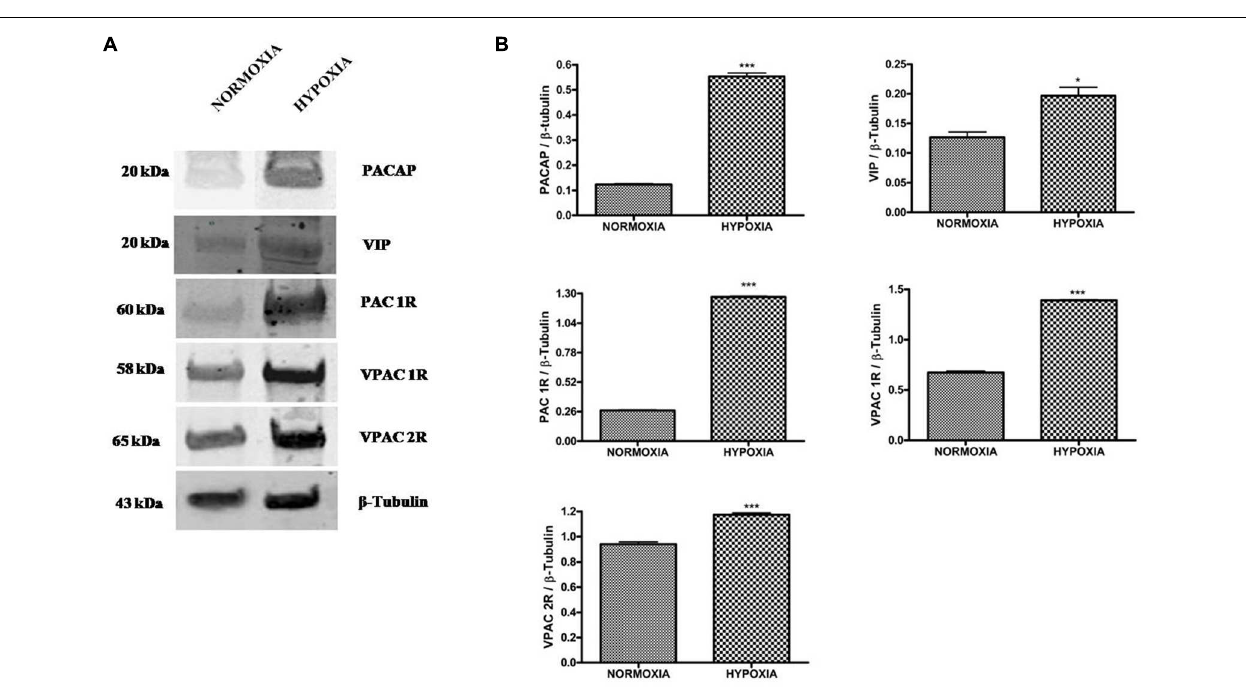
Frontiers in Pharmacology |